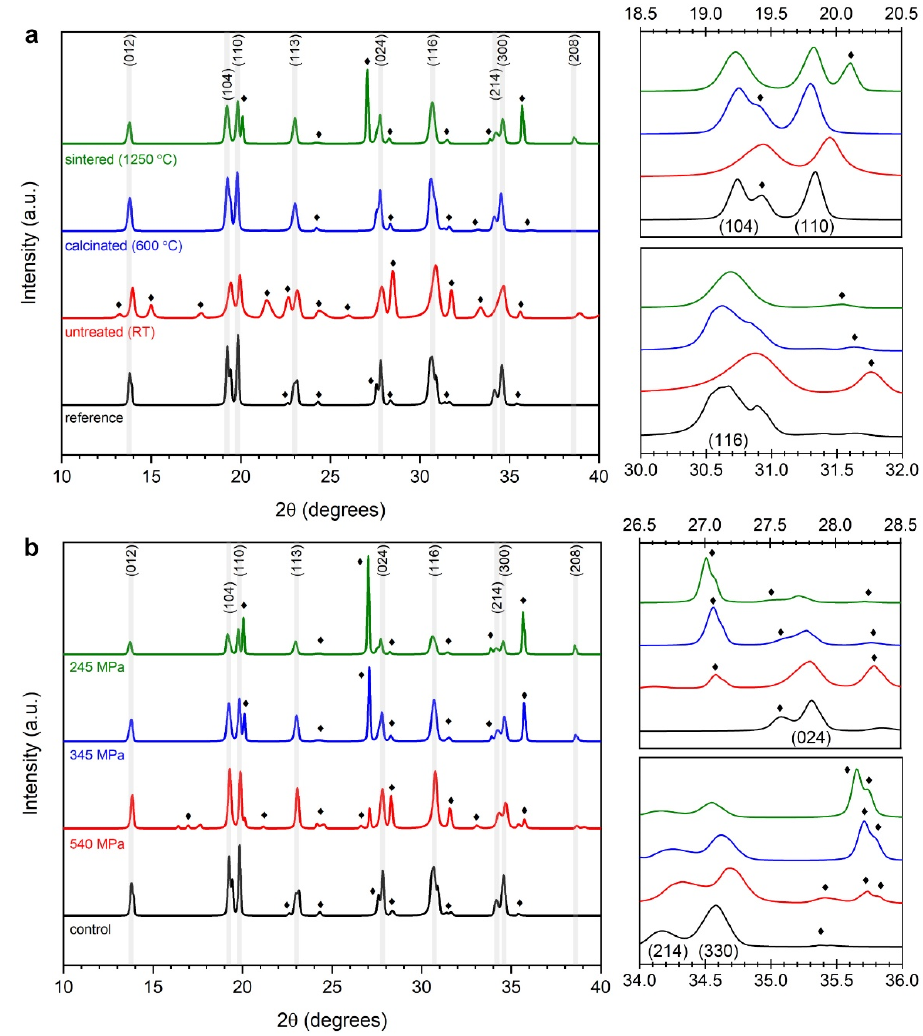
Figure 6. XRD spectra of NASICON signatures ( a ) over increasing processing temperatures and ( b ) over selected levels of isostatic pressure. Miller indices given above their corresponding 2 θ ranges; zirconia and other secondary phases marked as black ♦ . Side-panels correspond to focused displays of characteristic peaks of interest (scaling not proportional for readability).